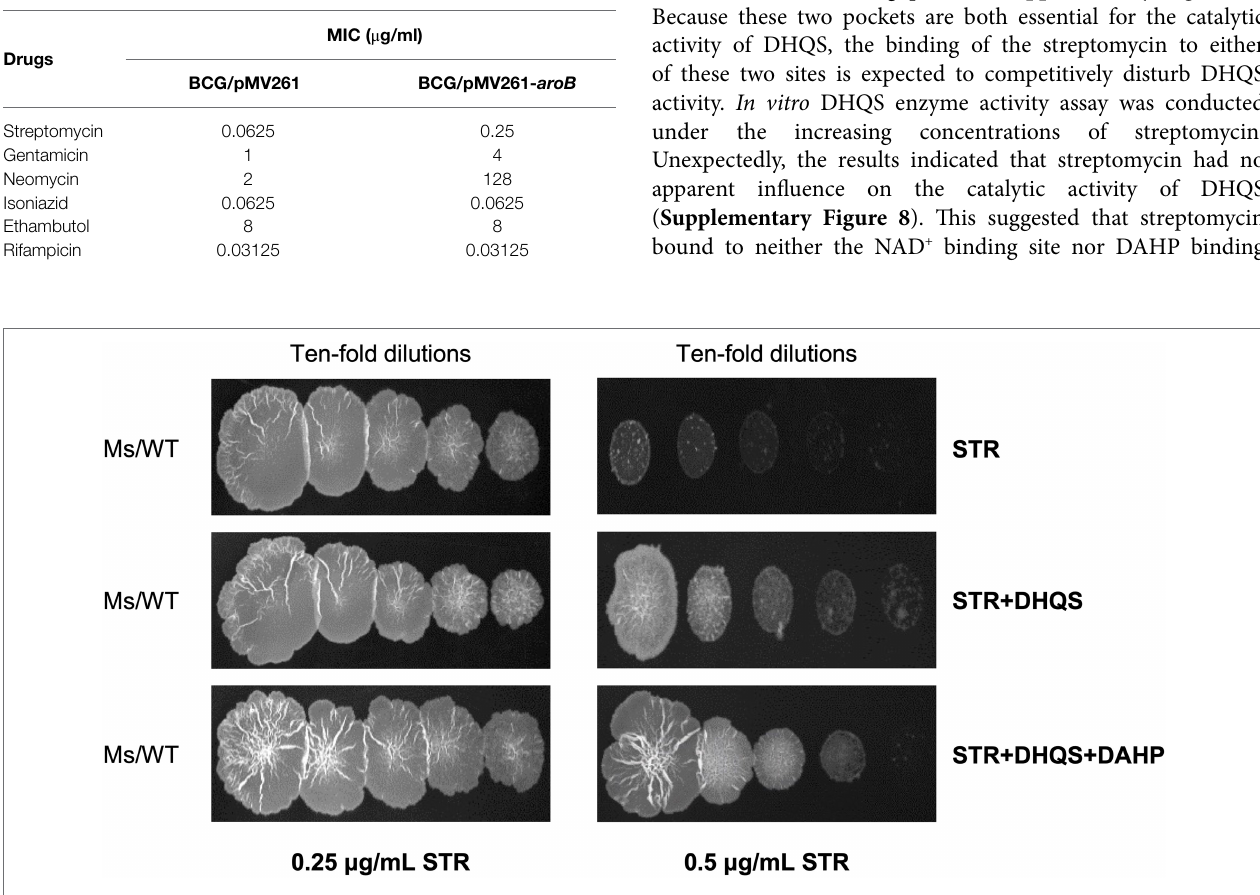
FIGURE 2 | Dehydroquinate synthase impairs in vitro antibacterial activity of streptomycin. The 0.25 or 0.5 μ g/ml streptomycin was incubated with 1.5 μ M DHQS in the presence or absence of 3-deoxy-D-arabino-heptulosonate 7-phosphate (DAHP) substrate for 30 min at 37 ° C. The reaction mixture was added to the 7H10 plate. Wild-type Mycobacterium smegmatis grown to the logarithmic phase was serially diluted (10 − 0 , 10 − 1 , 10 − 2 , 10 − 3 , and 10 − 4 ), and equal amount of culture was spotted on the solid plate and cultivated for 3